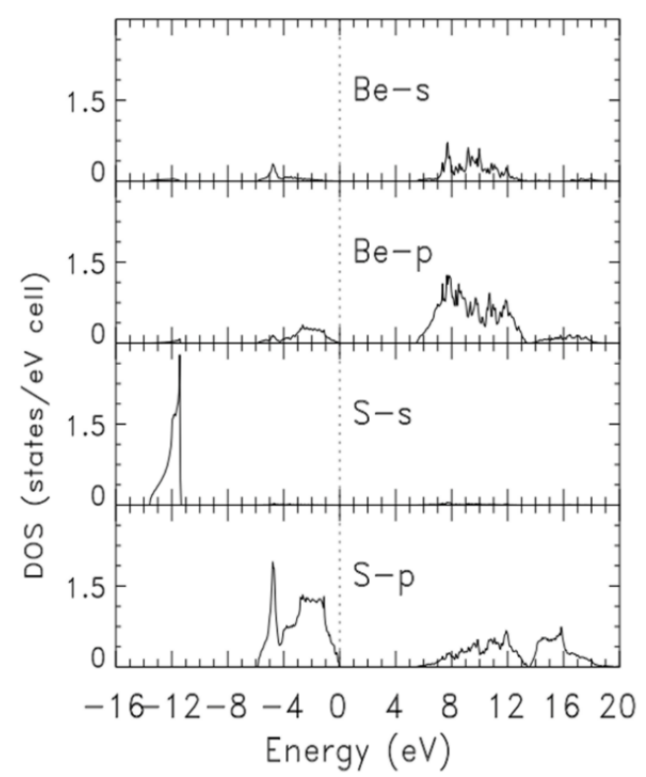
Figure 3. Calculated partial densities of states (pDOS) of zb-BeS derived from the ground state band structure from calculation III.